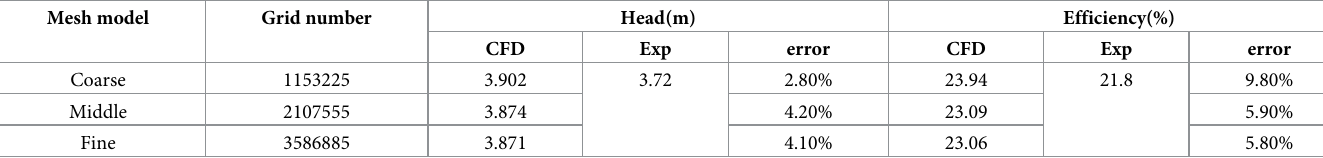
Table 1. Pump head and pump efficiency calculated by different mesh models. Mesh